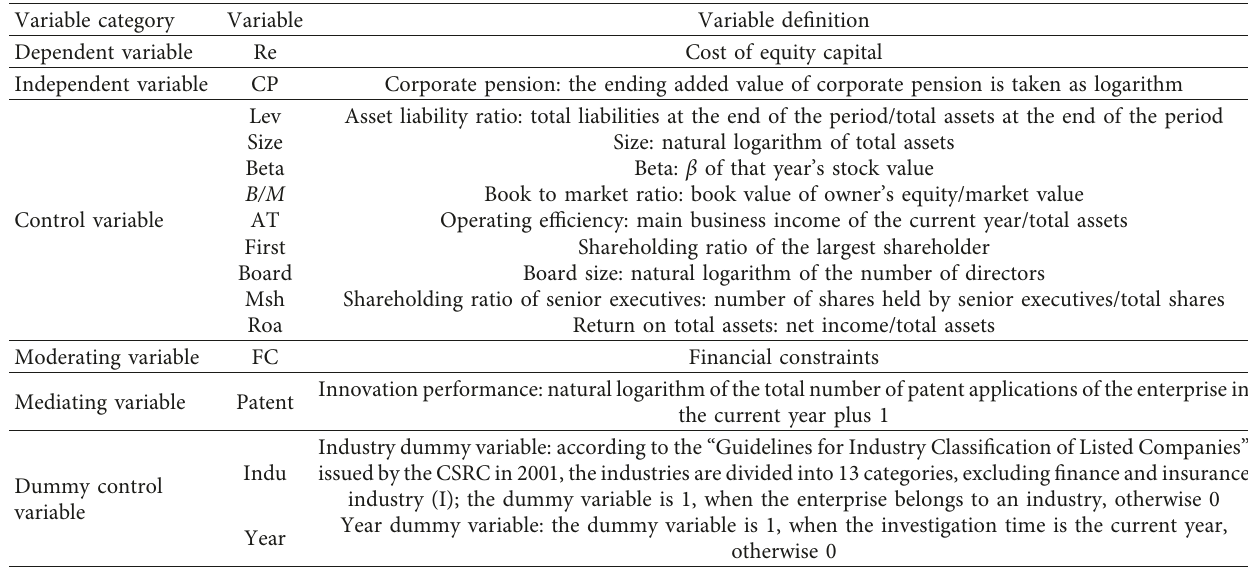
Table 1: Variable